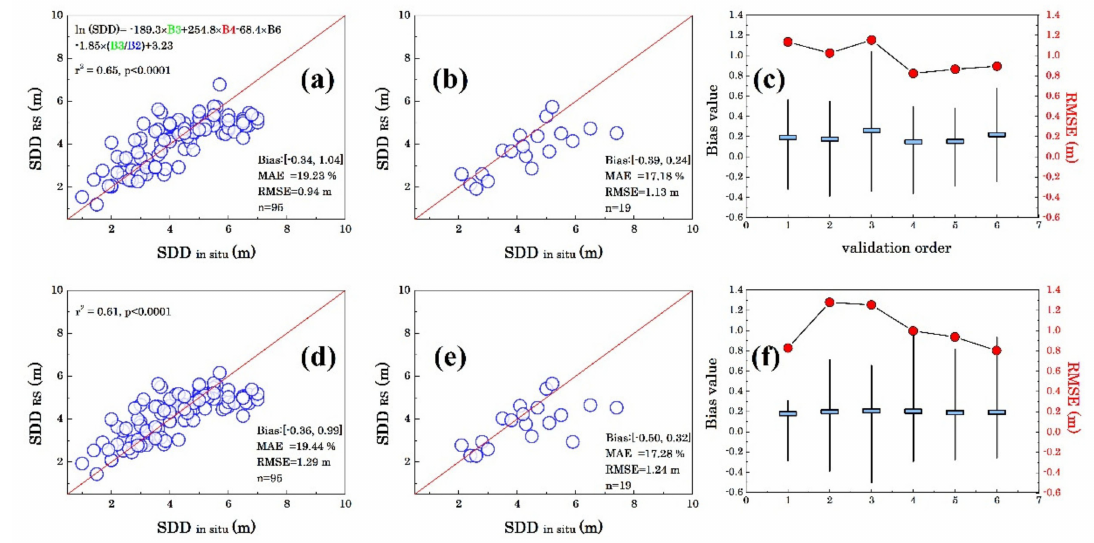
Figure 5. Comparing SDD RS and SDD in situ based on the modeling ( a , d ) and validation ( b , e ) dataset, respectively. ( c , f ) were sensitivity analysis results on the selection of validation samples. The first row showed the results for the stepwise method and the second row displayed the results for the SVM